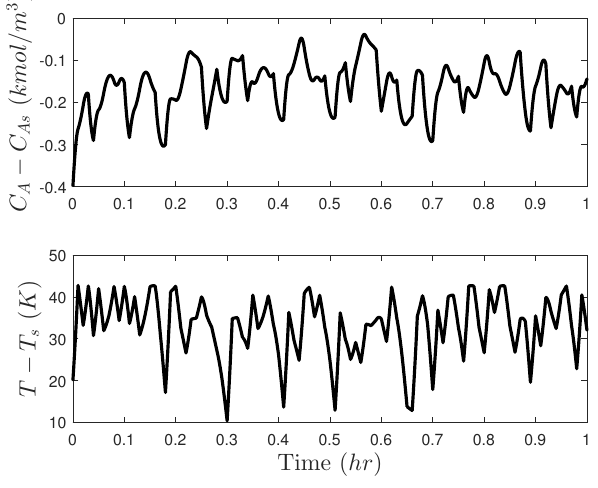
Figure 7. State trajectories under the randomized LMPC implementation strategy for the CSTR of Equations (46) and